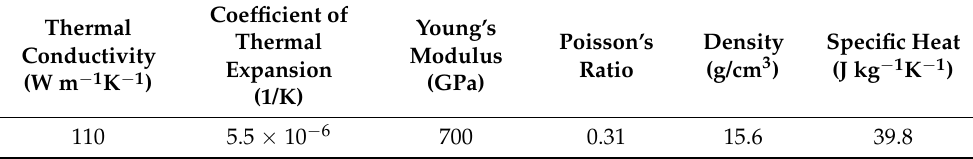
Table 3. Properties of the cutting tool